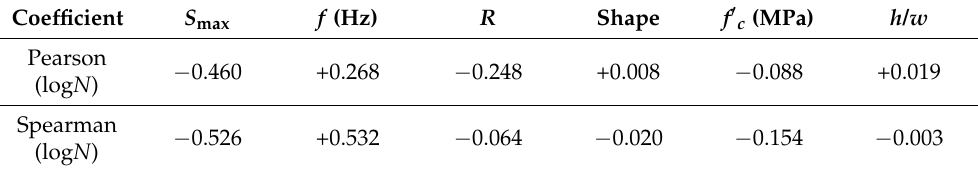
Table 7. Pearson and Spearman correlation coefficient.